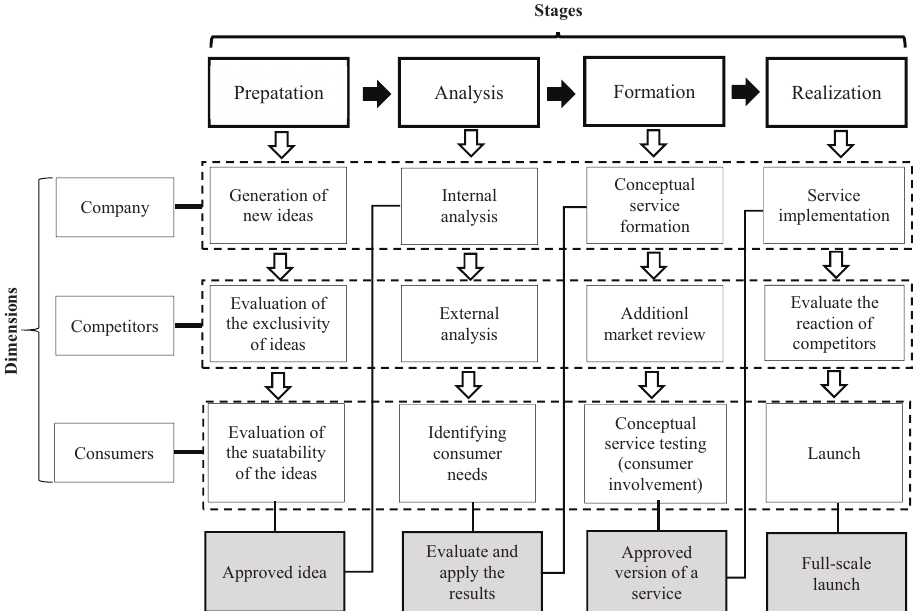
Figure 1. Principal scheme of the NSD model (source: Švogžlys,